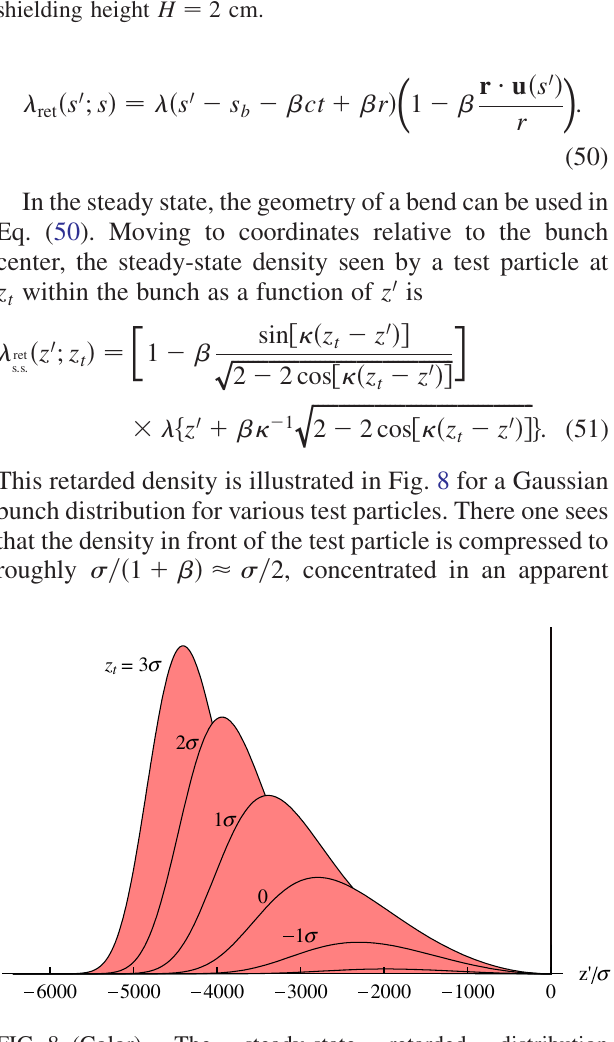
FIG. 8. (Color) The steady-state retarded Gaussian bunch with standard deviation (cid:10) ¼ 0 : 3 mm and en- ergy 1 GeV, in a magnet of bending radius (cid:7) (cid:1) 1 ¼ 10 : 0 m .